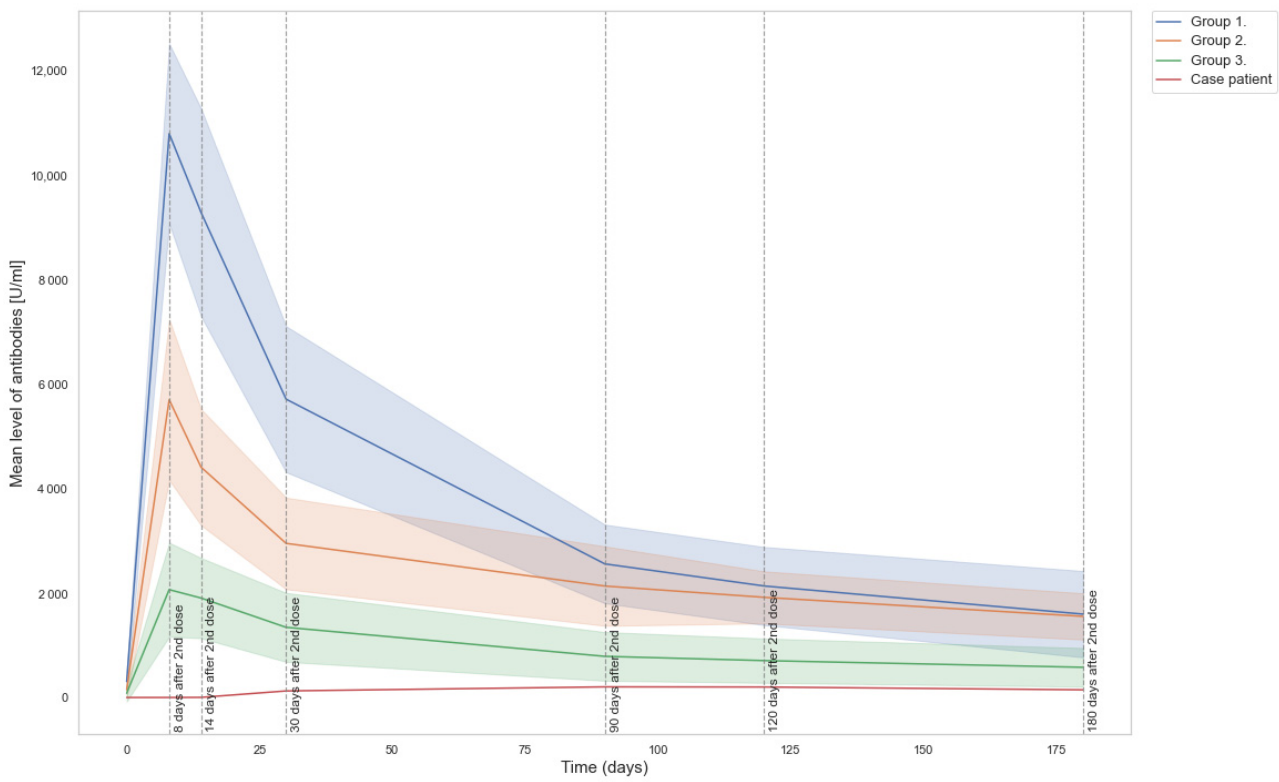
Figure 1. Dynamics of change in levels of SARS-CoV-2 antibodies post second dose of the vaccine (for each group mean antibody level with shading representing SD). Participants were divided into groups based on the antibody level on day 8 after the second vaccine dose: group 1 ( n = 5) above 8000 U/mL, group 2 ( n = 7) 4000–8000 U/mL, and group 3 ( n = 39) below 4000 U/mL.